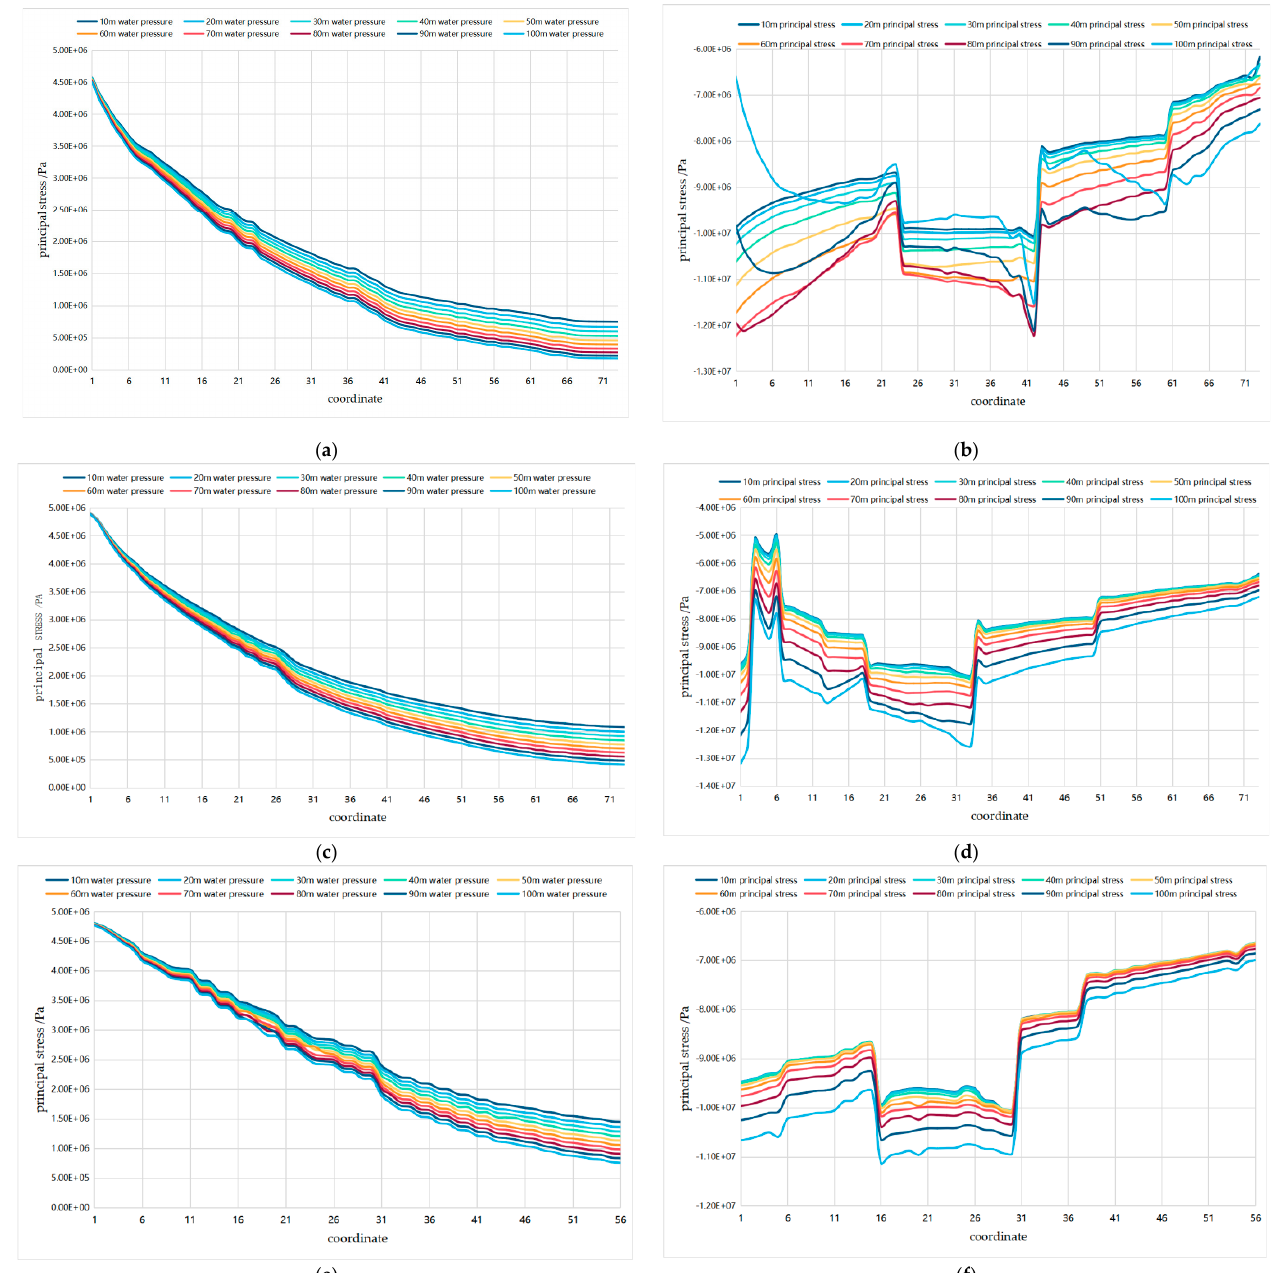
Figure 6. Water pressure values and principal stress values. ( a ) 30 ◦ fault dip water pressure. ( b ) 30 ◦ fault dip first principal stress. ( c ) 45 ◦ fault dip water pressure. ( d ) 45 ◦ fault dip first principal stress. ( e ) 60 ◦ fault dip water pressure. ( f ) 60 ◦ fault dip first principal